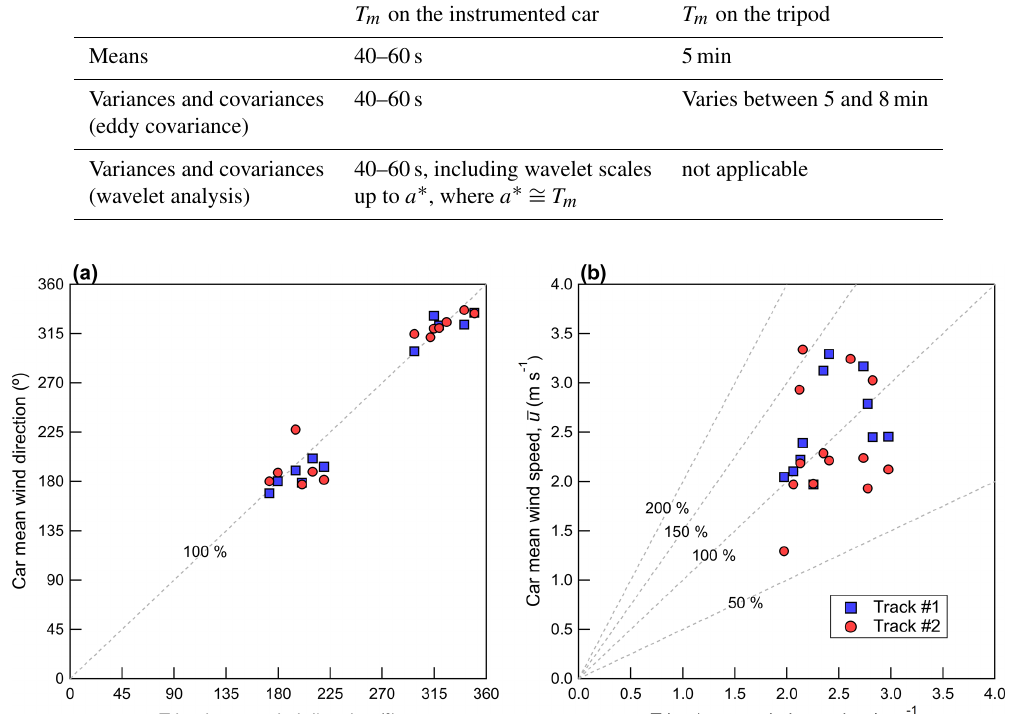
Figure 5. A scatter plot showing the mean wind direction (a) and mean wind speed (b) measured by the tripod and compared to the mobile car. Dashed gray lines denote constant percentages of the independent